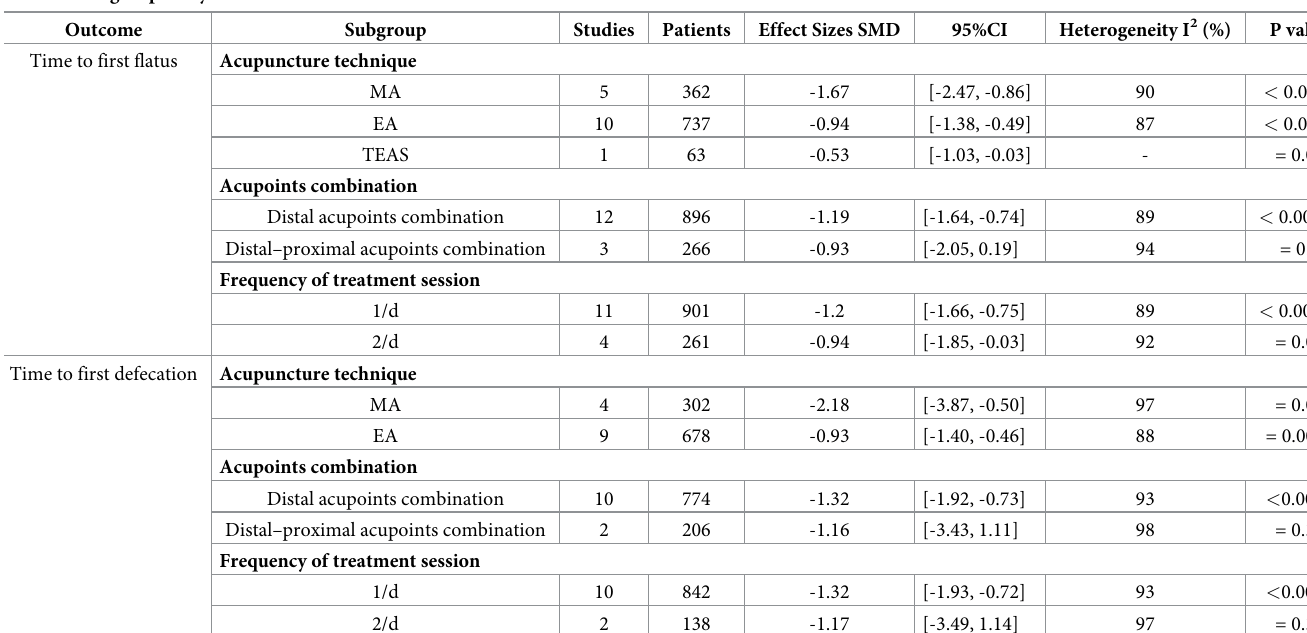
Table 3. Subgroup